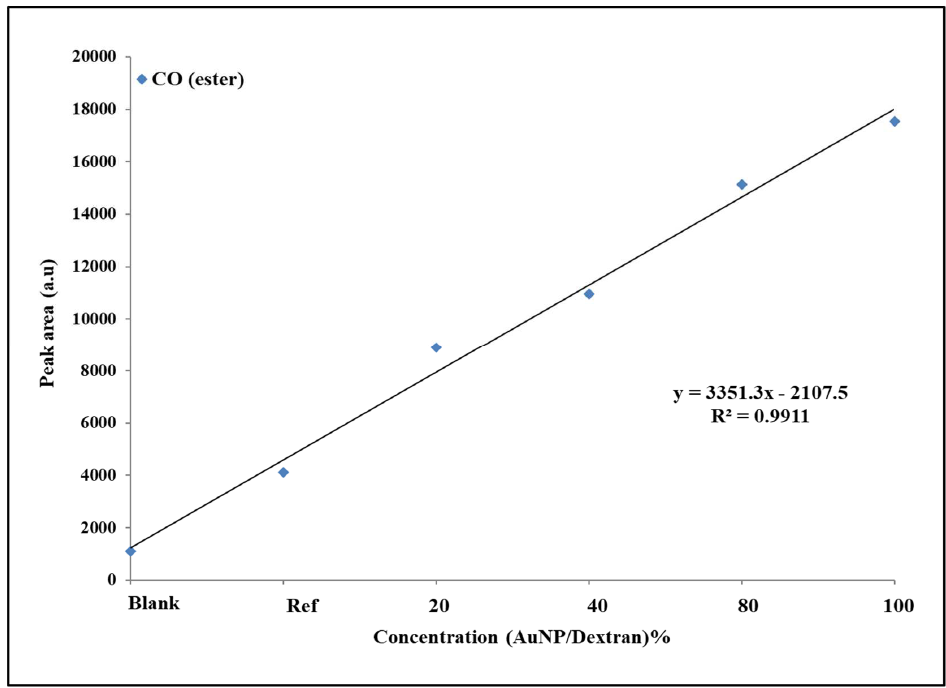
Figure 6. Linear plot of PA (ester) vs. Au/dextran concentration. The blank sample is 5% dextran, while the reference is 10% ASA in 5% Au/dextran NP solution. Experiments were performed in triplicate for each group. ( n = 3, SD 1.5–2.5). R 2 =